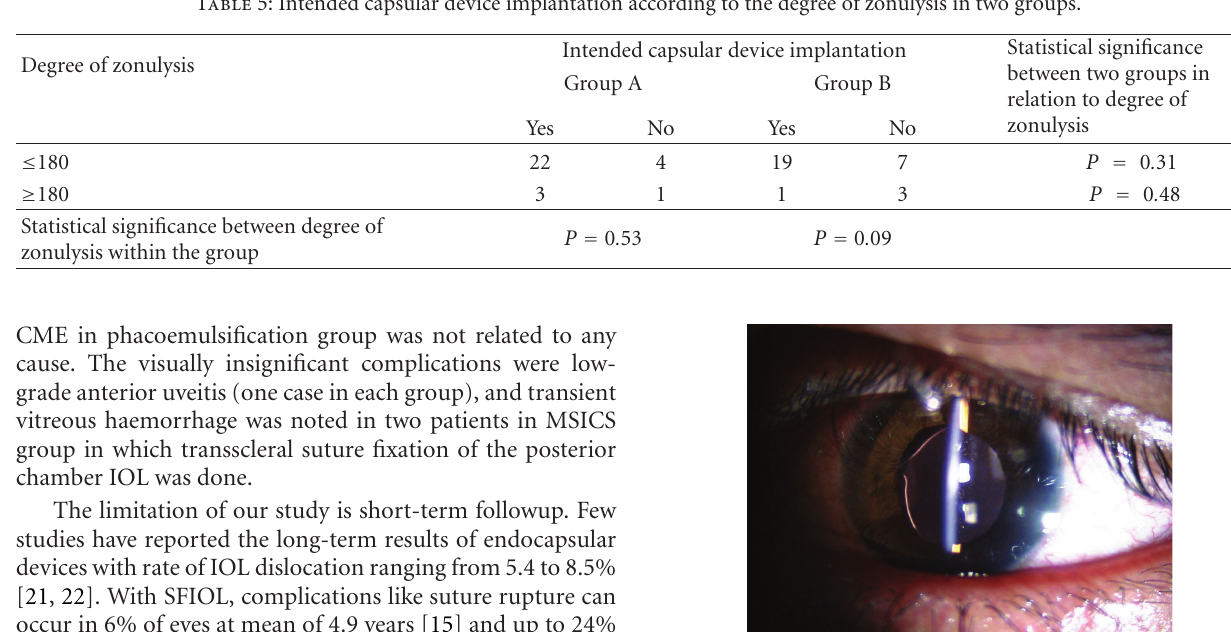
Table 5: Intended capsular device implantation according to the degree of zonulysis in two groups.